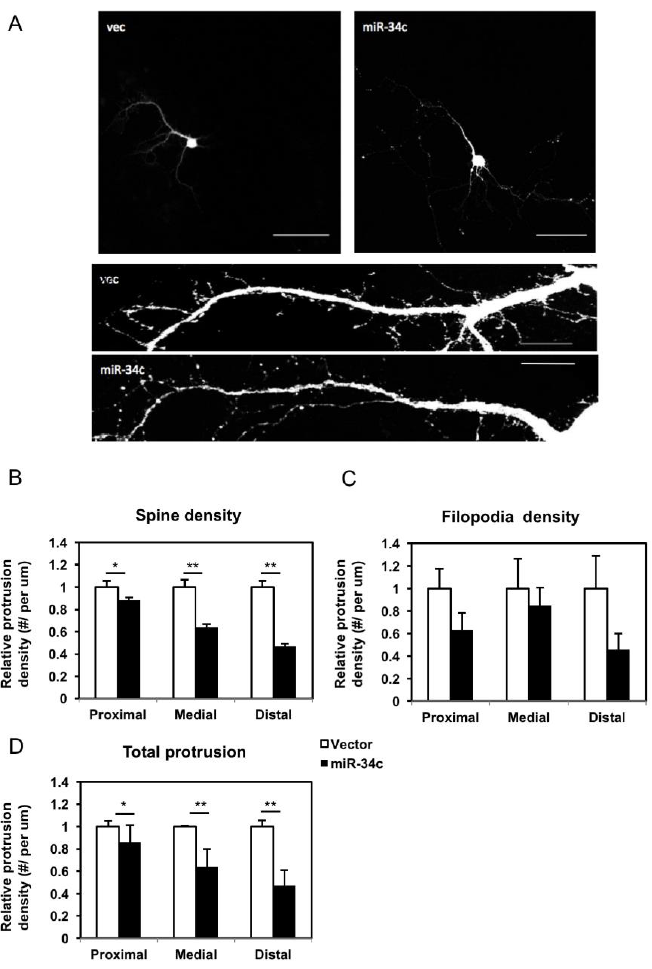
Figure 5. We observed that miR-34c exerted a negative effect on spine density along the dendrites. ( A ) Low- and high-power fields (20 × in upper panels and 100 × in lower panels) were used for counting. Scale bar of upper panel = 100 µ m, lower panel = 20 µ m. Quantification of the densities of ( B ) spines, ( C ) filopodia, and ( D ) total protrusions was conducted by dividing each dendrite into three equal segments of 40- µ m in length, starting from the soma as the proximal segment (0–40 µ m) and followed by the middle (40–80 µ m) and distal (80–120 µ m) segments, and calculated using a two-tailed Student’s t -test (* p < 0.05, ** p < 0.01).